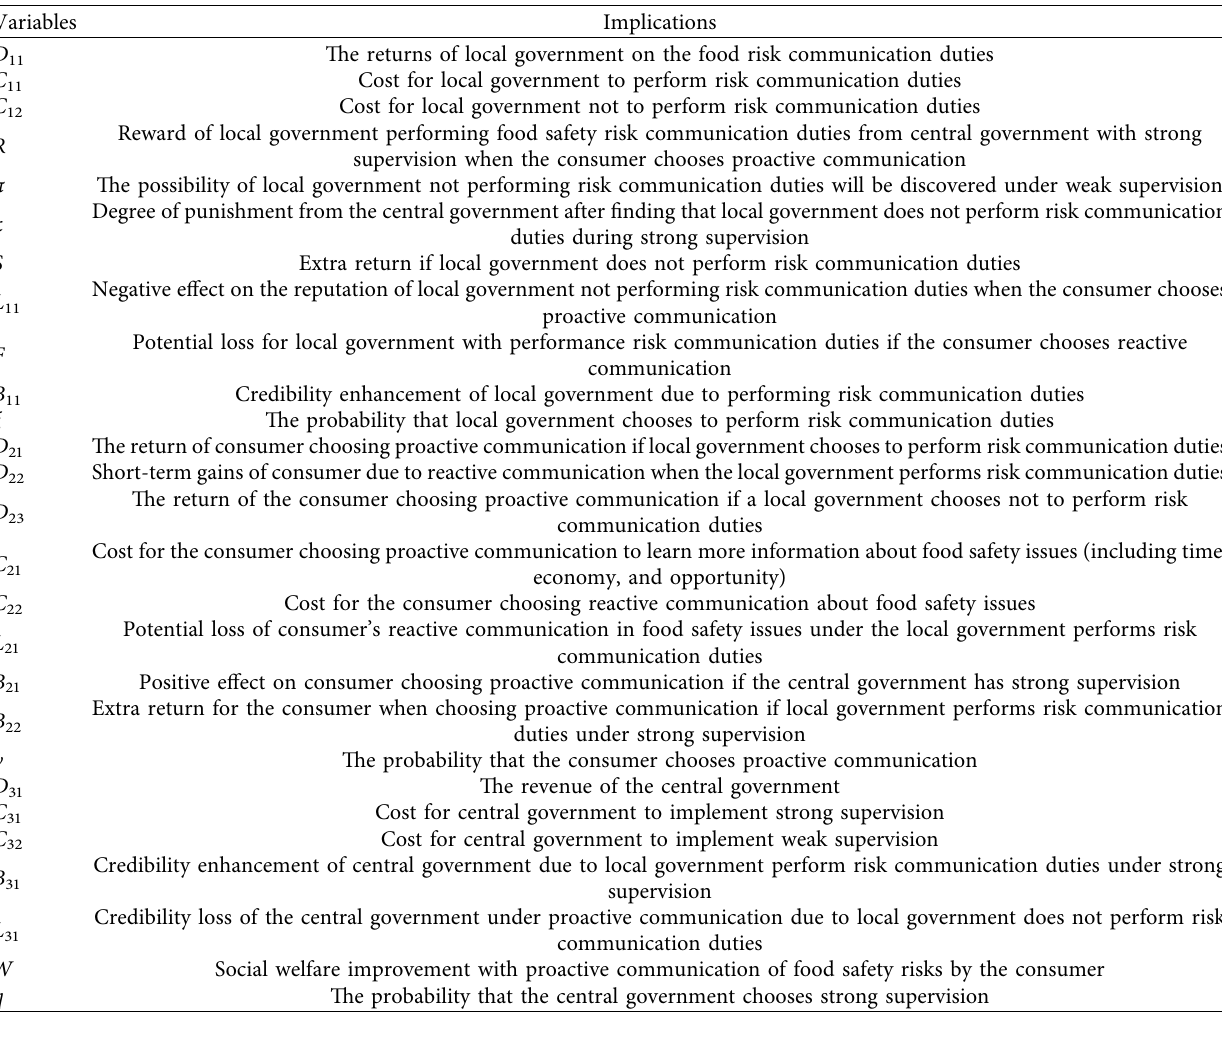
Table 1: Description of model parameters.